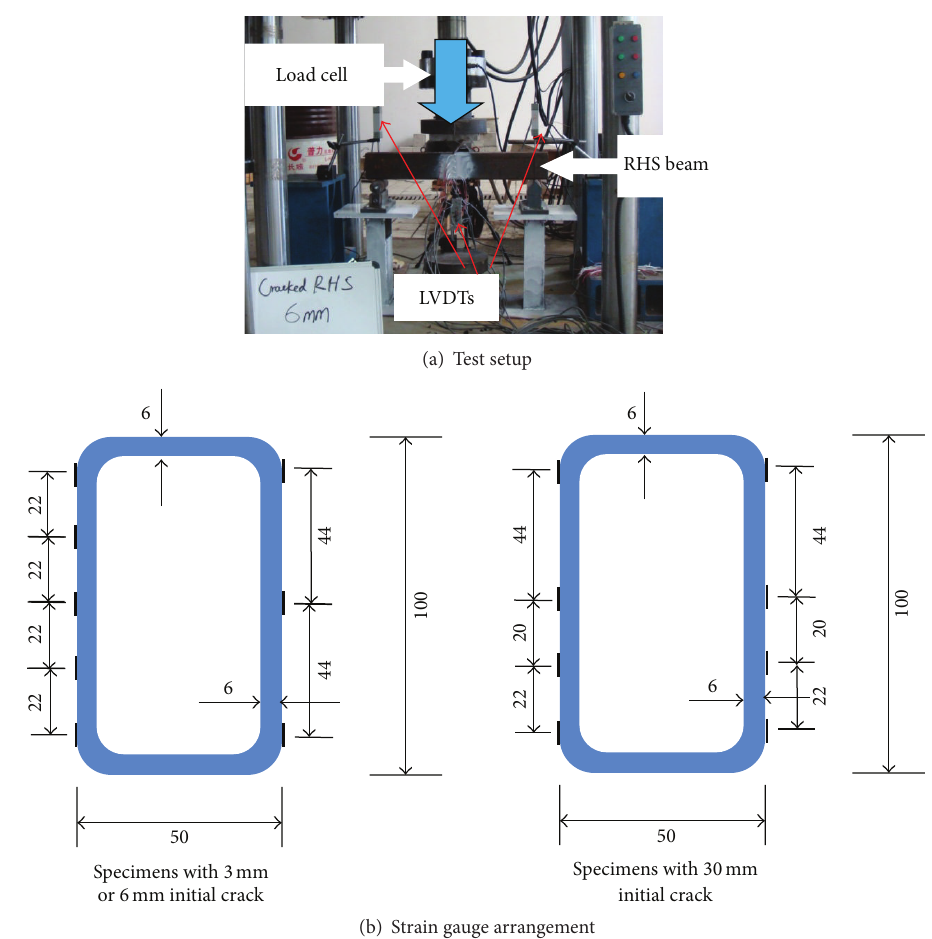
Figure 3: Test setup and